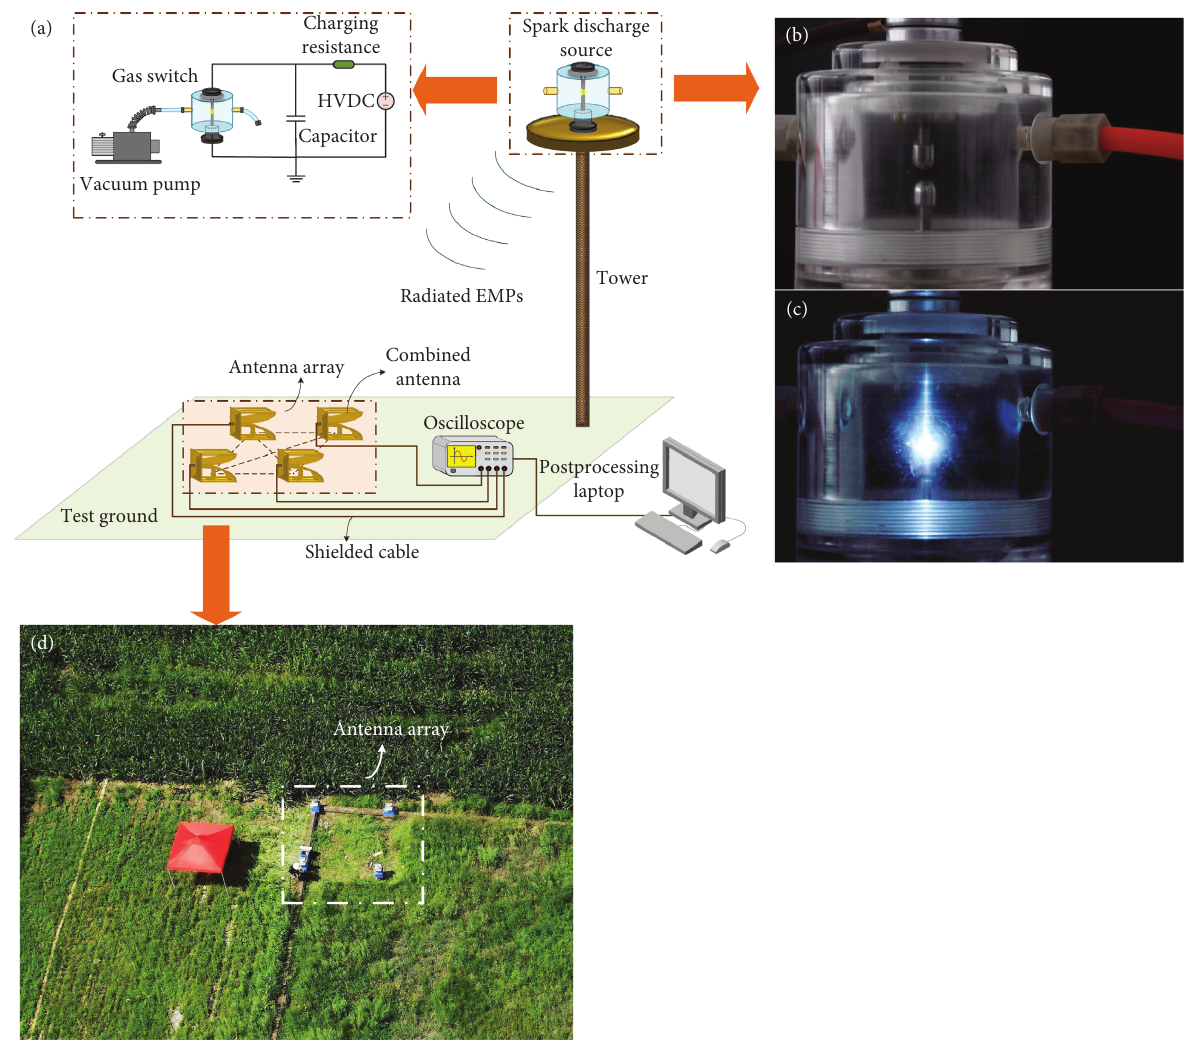
Figure 1: Experimental setup.